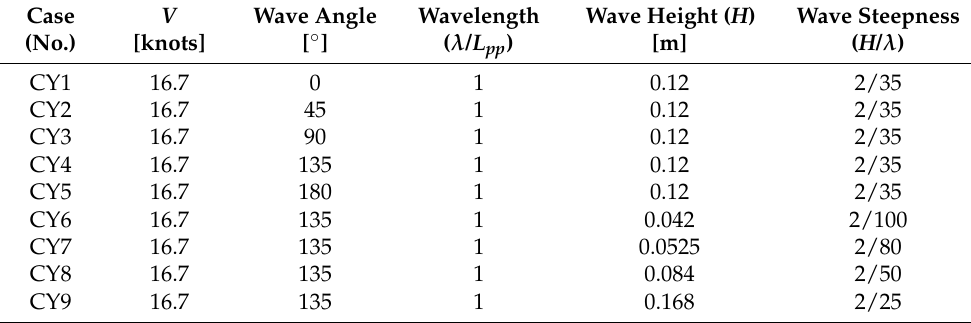
Figure 16. Time histories of heave and pitch motions in waves (Case CYB). ( a ) Heave; ( b ) Pitch. Table 6. Test Cases of “Yukun”.